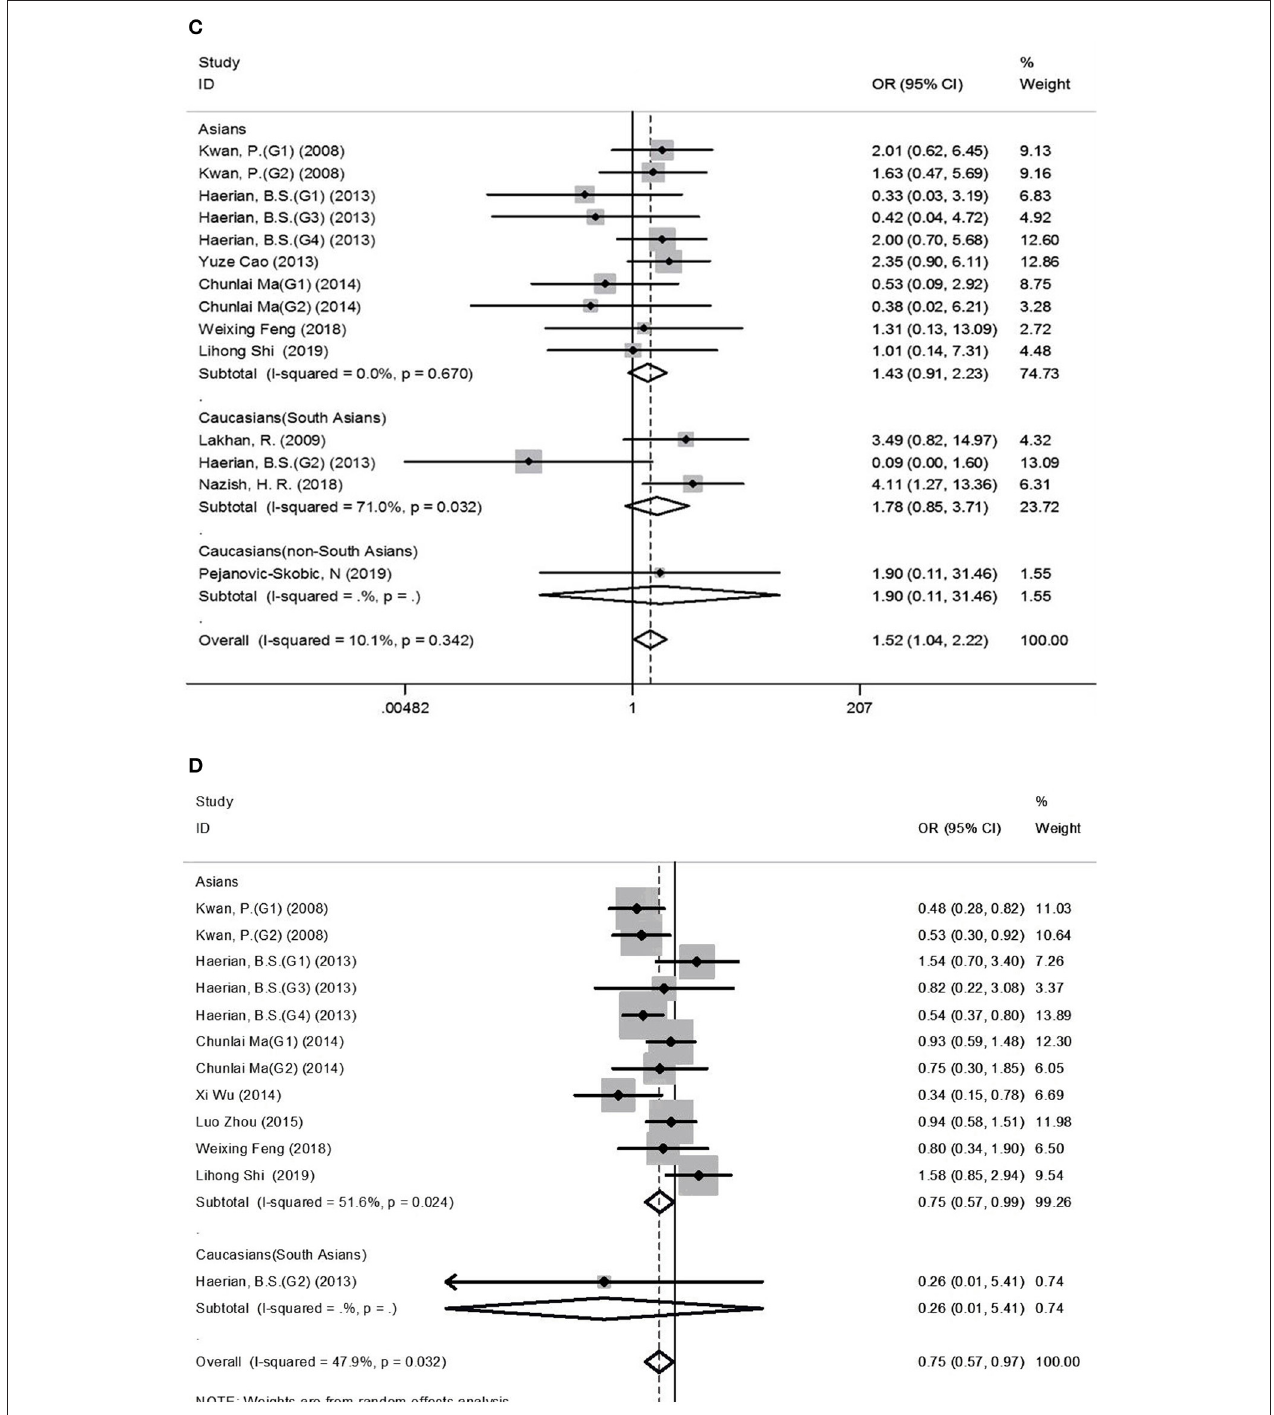
FIGURE 2 | Forest plots for the association between the SCN1A rs2298771, SCN1A rs10188577, SCN2A rs17183814, and SCN2A rs2304016 polymorphisms and resistance to antiepileptic drugs. (A) , SCN1A rs2298771 polymorphism (GG vs. AA). (B) SCN1A rs10188577 polymorphism (C vs. T). (C) , SCN2A rs17183814 polymorphism (AA vs. GG). (D) SCN2A rs2304016 polymorphism (G vs. A). The sizes of the squares reflect the study’s weight and horizontal lines represent 95% CI; the center of diamonds reflects the overall odds ratio (OR), and the horizontal span of the diamond represents the 95% CI of the OR.